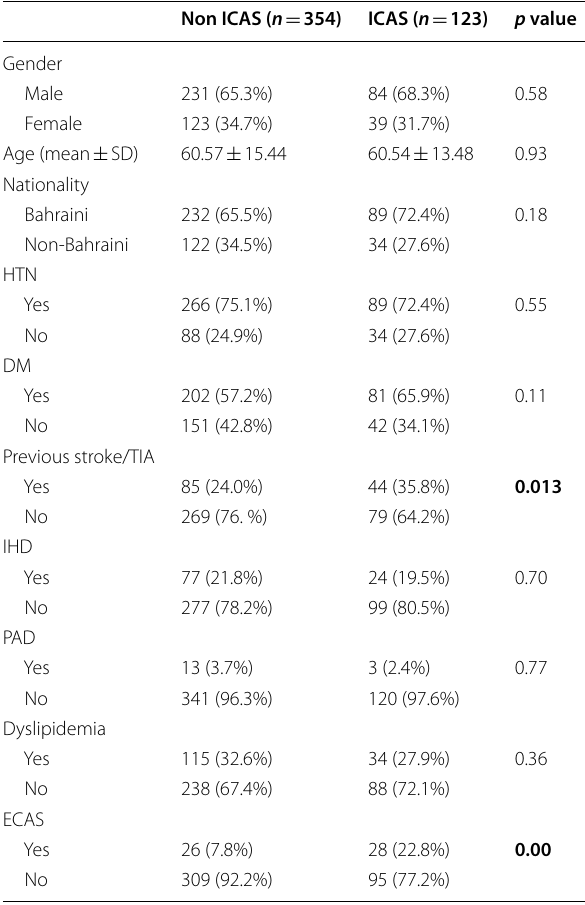
Table 1 Distribution of demographic and vascular risk